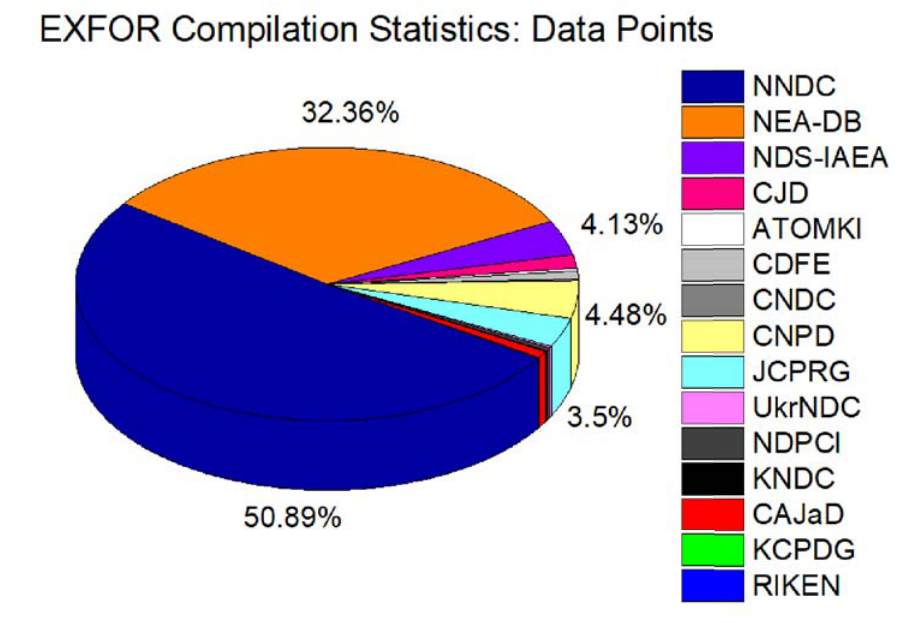
Figure 2. EXFOR compilation statistics include data points from the currently operating NNDC Brookhaven, NEA-DB Paris, NDS IAEA Vienna, CJD Obninsk, ATOMKI Debrecen, CDFE Moscow, CNDC Beijing, CNPD Sarov, JCPRG Sapporo, UkrNDC Kyiv, NDPCI BARC / India, KNDC